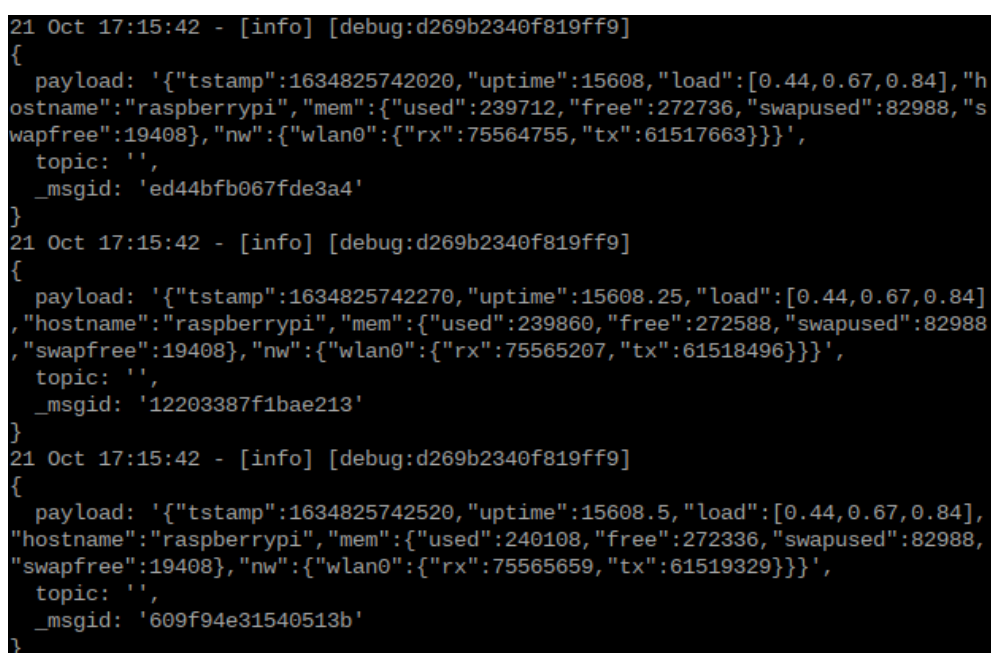
Figure 7. MQTT-based DoS attack on smart